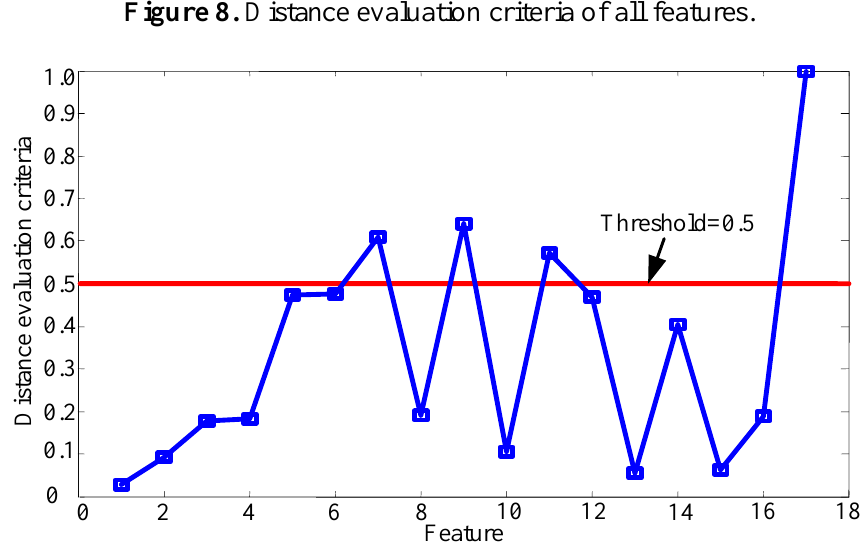
Figure 8. Distance evaluation criteria of all